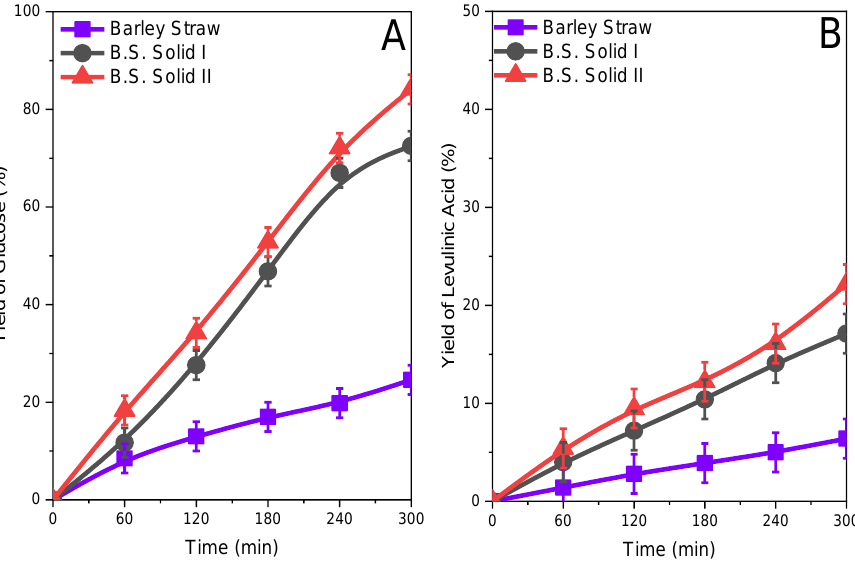
Figure 6. Glucose ( Graph A ) and levulinic acid ( Graph B ) yields after the hydrolysis of the original barley straw and barley straw solids obtained (Solid I and Solid II) after treatment with ISH.